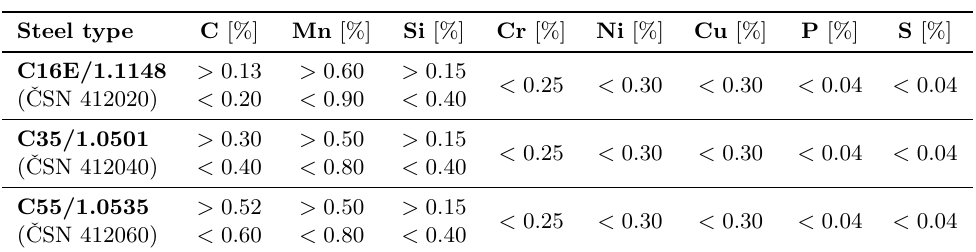
Table 1. Chemical composition of the steel group used for test samples (composition acc. to Czech standards ČSN 412020, ČSN 412040 and ČSN 412060).